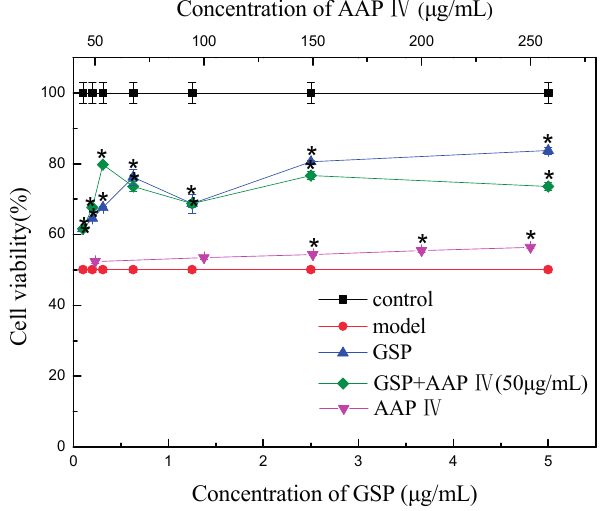
Figure 4. Effect of GSP, AAP IV, and their combination on viability of splenocytes. * indicates a significant difference from the model ( p < 0.05).